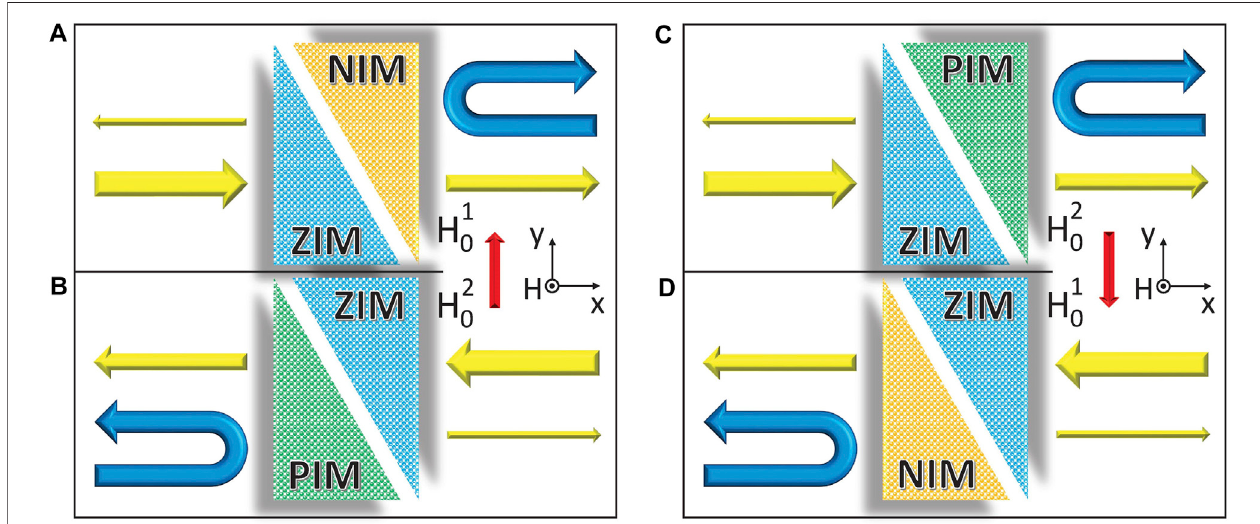
FIGURE 1 | Schematic diagram illustrating the recon fi gurable unidirectional propagation by HSMMs with ZIMs, NIMs, and PIMs as the building blocks. (A) For the HSMMmadeupoftheZIMandNIM,theLHSincidencecorrespondstothe “ passing ” stateasmarkedbytheyellowarrows,whiletheRHSincidencecorrespondstothe total re fl ection as marked by the blue arrows. (B) By decreasing the BMF from H 1 0 to H 2 0 , the HSMM is turned into that made up of the PIM and ZIM, thus leading to the “ passing ” state forthe RHS incidence, while LHS incidence isforbidden, giving rise tothe recon fi gurable unidirectionality from the “ LHS passing ” state tothe “ RHS passing ” state. For the second kind of HSMM shown in (C,D) , the recon fi gurability is functionalized by increasing the BMF from H 2 0 (C) to H 1 0 (D) , resulting in the transformation from the “ LHS passing ” state to the “ RHS passing ” state. Although the recon fi gurable unidirectionality in (A,B) is the same as that in (C,D) , the beam steering effect is